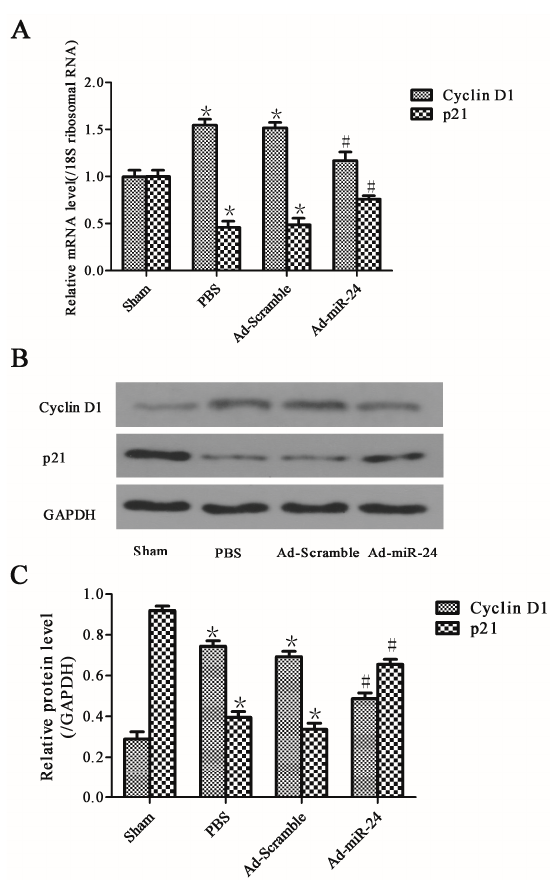
Figure 6. Effects of miR-24 over-expression on cell cycle-associated molecules: ( A ) The mRNA levels of Cyclin D1 and p21; ( B ) Representative immunoblots of cell cycle-associated molecules Cyclin D1 and p21; ( C ) Bar graphs of corresponding densitometric analyses of Western blots (compared to Sham group, * p < 0.05; compared to PBS group or Ad-Scramble group, # p < 0.05, n = 6).